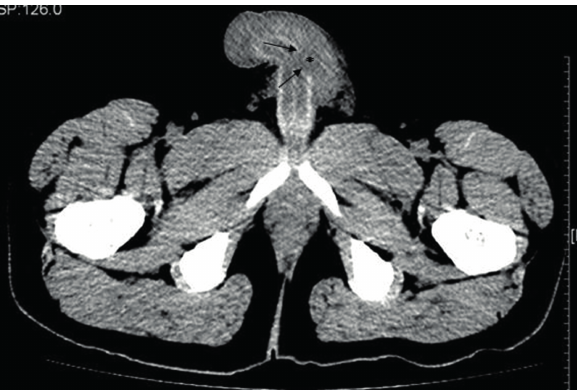
Figure 2 - Twenty-eight - old man with penile fracture. Axial cT image obviously demonstrated unilateral 0.8cm x 1.4cm area of tear of the left lateral tunia albuginea with adjacent hematoma. Arrows indicate the free edges of tunica defect and asterisks show the associated